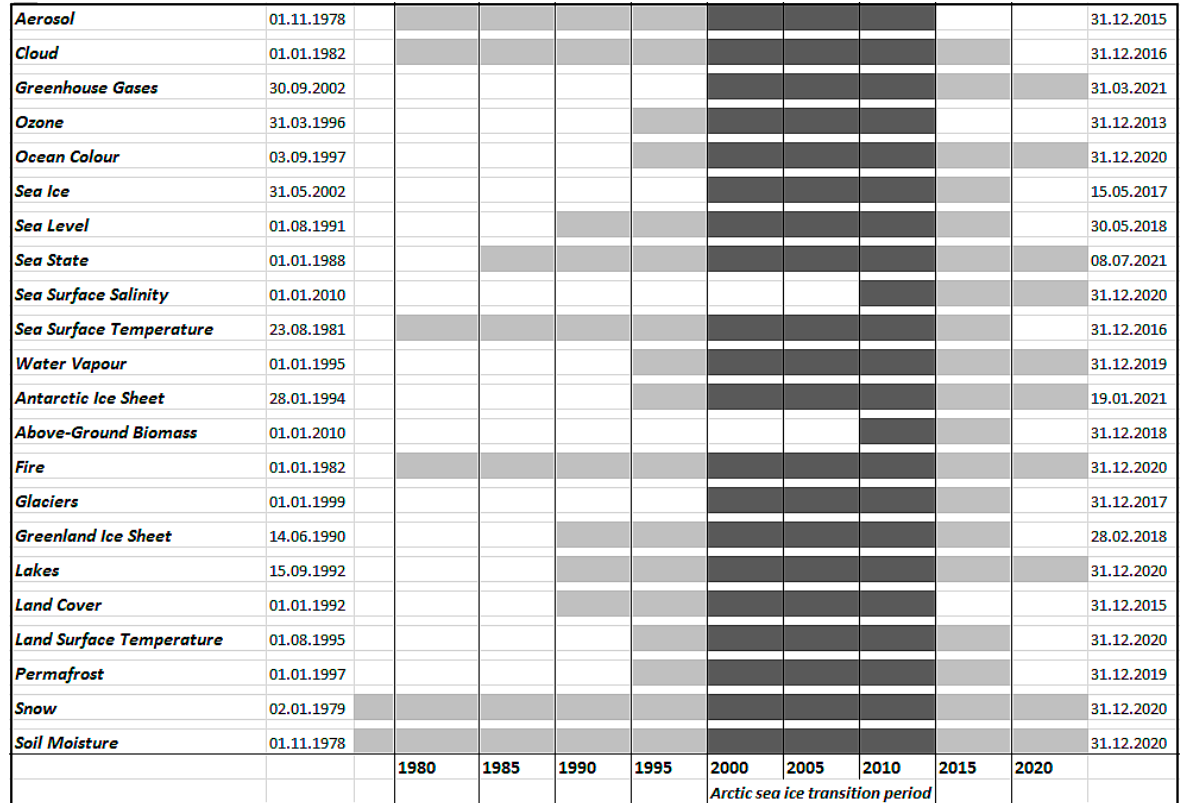
Figure 2. Temporal coverage of climate data records for ECVs in the ESA CCI. Dates and filled bars indicate availability of the data sets in the ESA CCI portal (https://climate.esa.int/ (accessed on 8 January 2023)) by the end of 2022. Dark shading indicates the period of apparent amplification emergence.